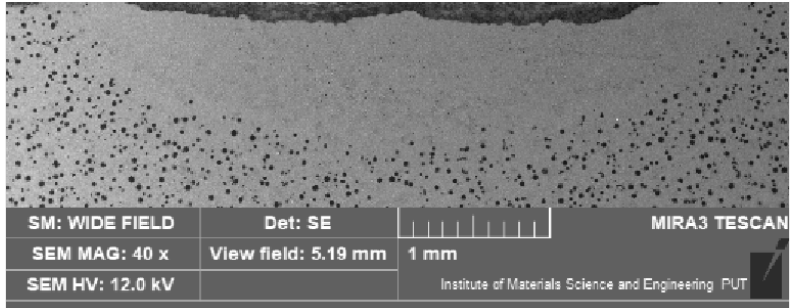
Figure 6. The cross-section of the surface layer of nodular iron after laser alloying with silicon (electron scanning microscope, etched with nital 3%).